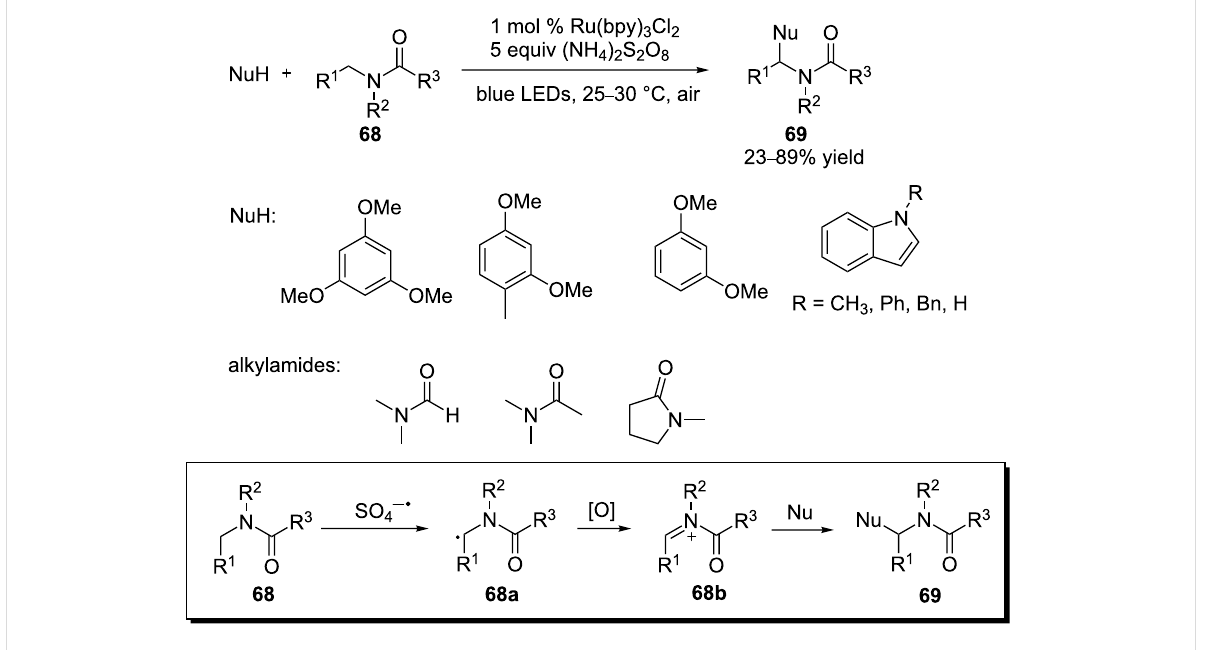
Scheme 17: Photoredox-catalyzed α -arylation of